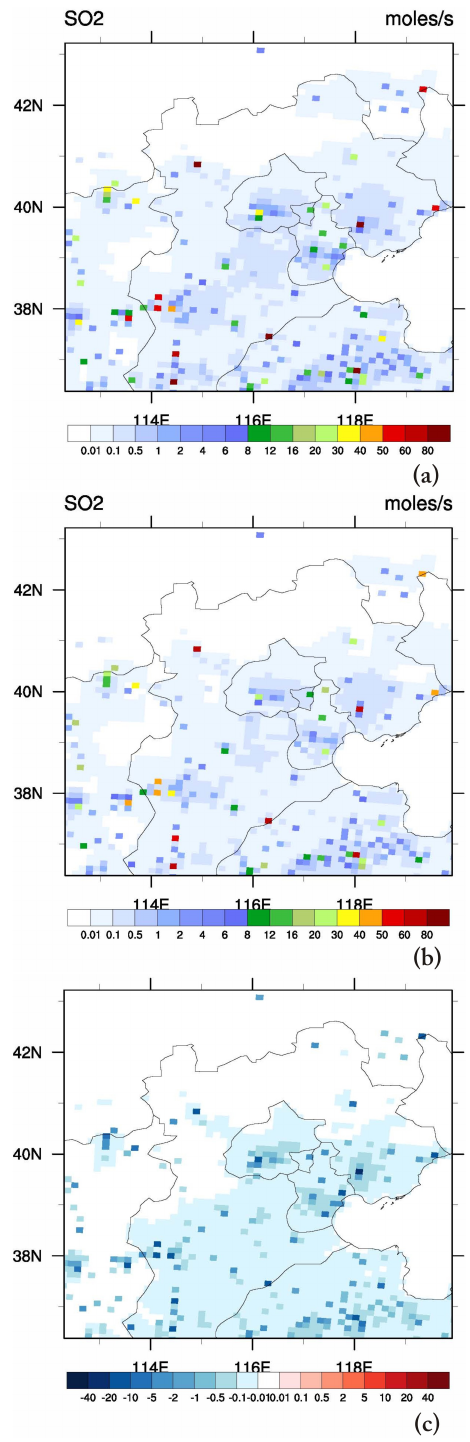
Fig. 8. Spatial distributions of anthropogenic SO 2 in and around Beijing with horizontal resolution of 12 by 12km 2 during the emis- sion (a) non-control and (b) control periods and (c) their differences in